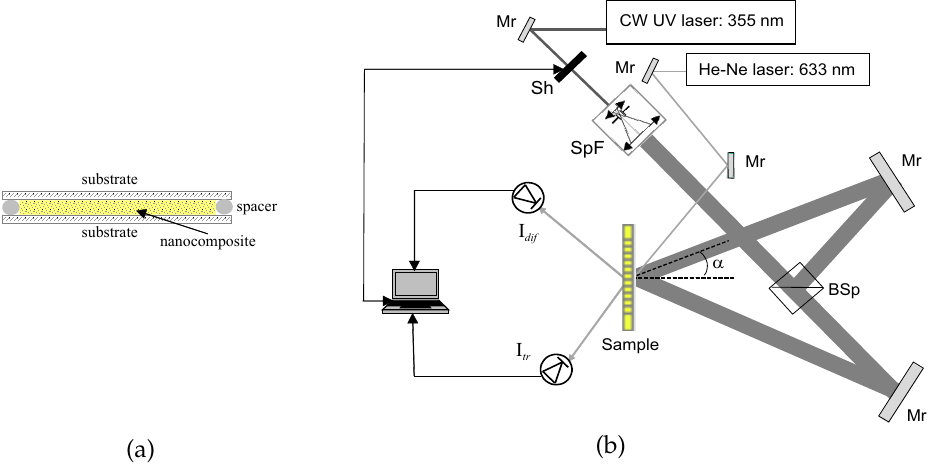
Figure 1. The sample preparation ( a ). Holographic setup for transmission gratings recording ( b ). Mr is the mirror; Sh is the shutter; SpF is the collimator with the spatial filter; BSp is the beam